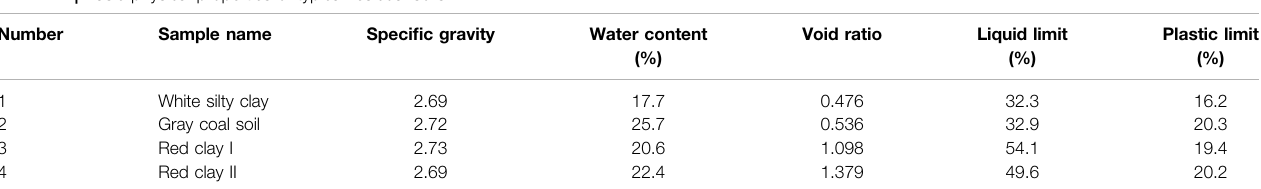
TABLE 1 | Basic physical properties of typical residual soils.